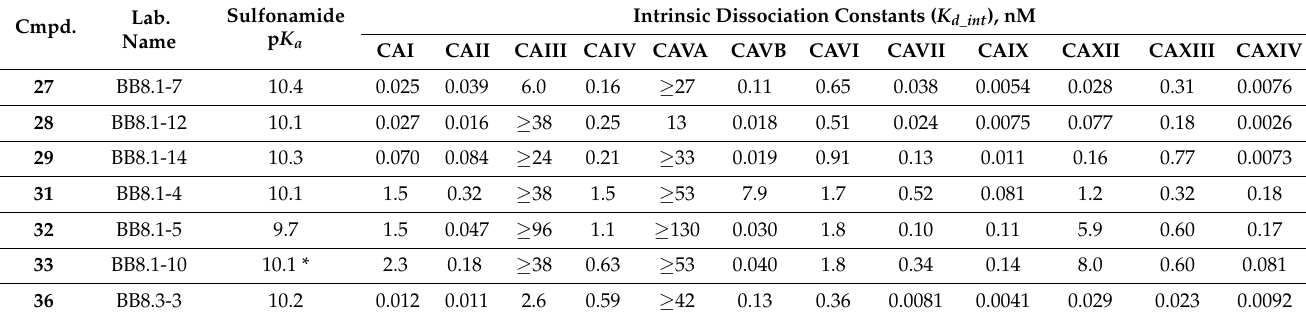
Table 3. The intrinsic dissociation constants ( K d_int ) for compounds binding to CAs at 37 ◦ C. ND—not determined. *—the p K a value was not determined and is an average of all measured compounds. Experimental data and statistics of p K a values are provided in Supplementary